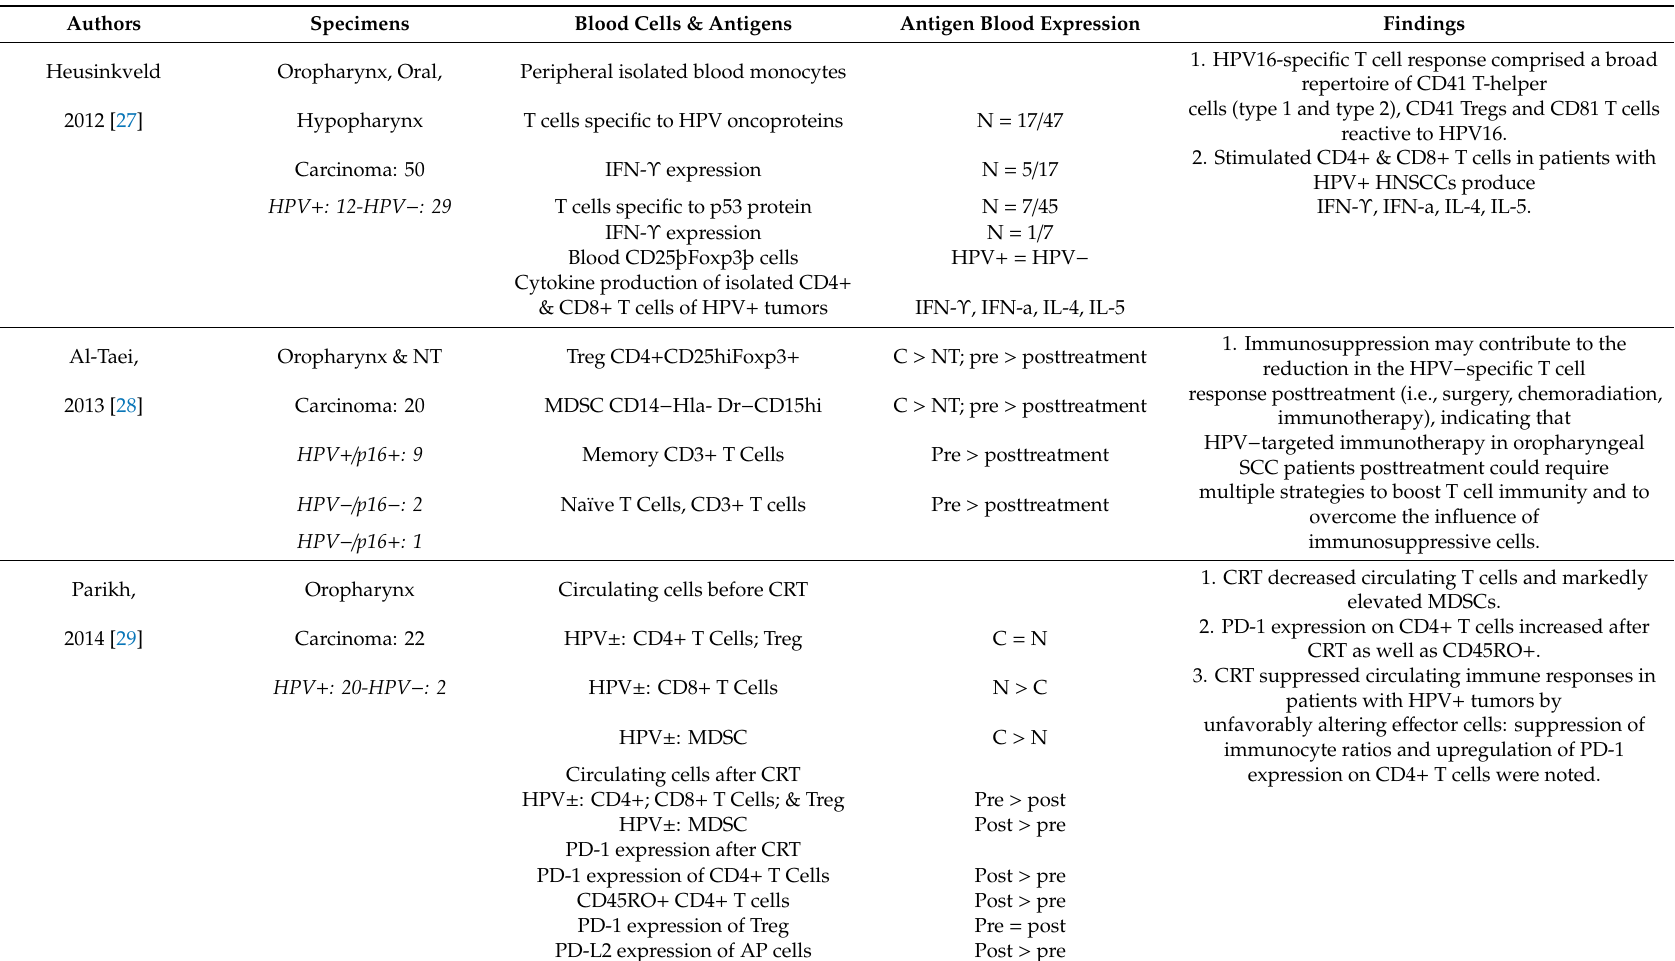
Table 2. Peripheral blood immune cell concentration of patients with head and neck squamous cell carcinoma according to HPV